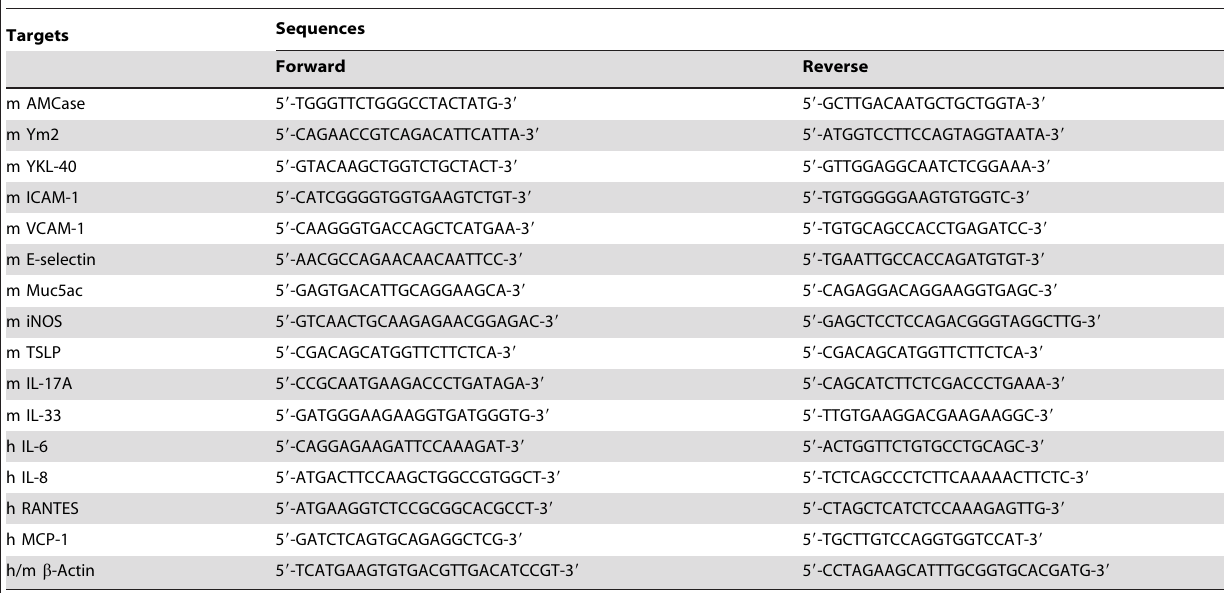
Table 1. Primer sets for reverse transcriptase-polymerase chain reaction analysis.